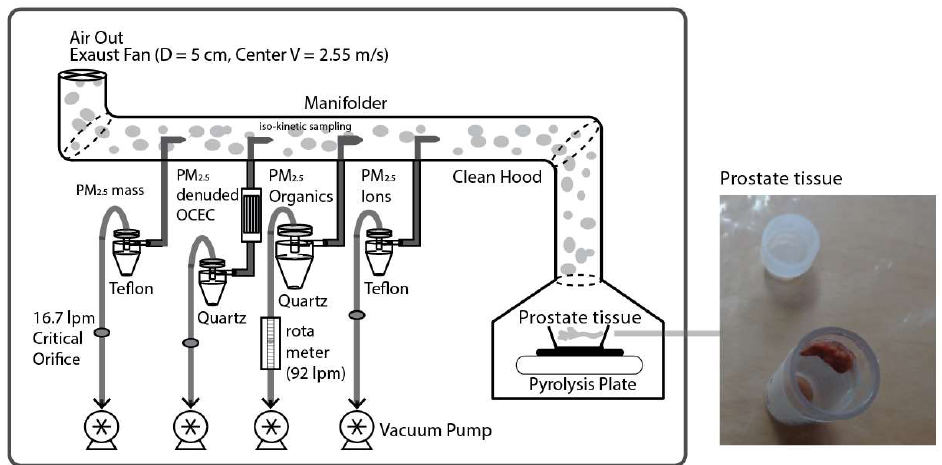
Figure 1. Schematic diagram of the pyrolysis sampling